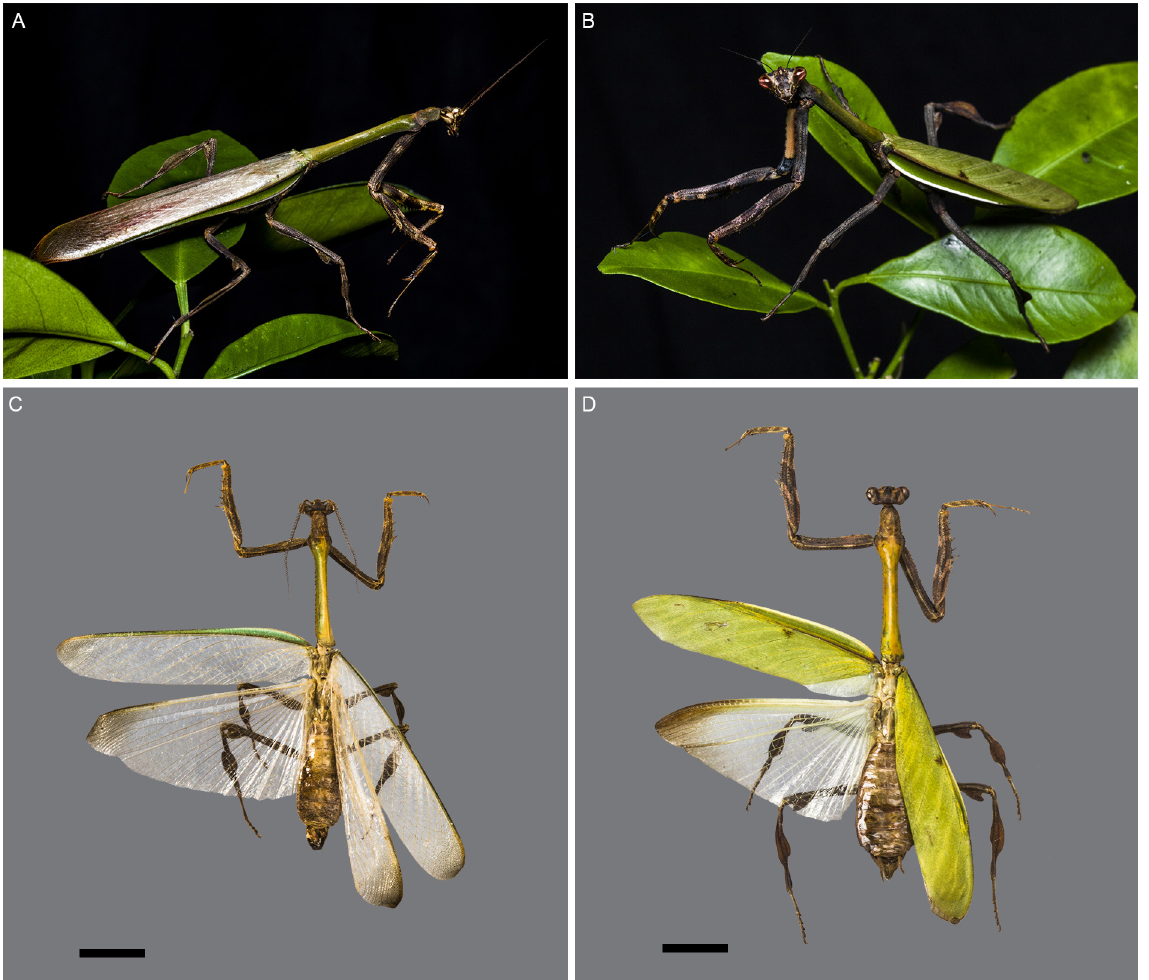
Fig. 2. Adults of Vates phoenix sp. nov. A – B . Live specimens photographed in a studio. A . Paratype, ♂, from Reserva Ecológica de Guapiaçu (MNRJ-ENT6-28446). B . Allotype, ♀, from Jardim Botânico do Rio de Janeiro (MNRJ-ENT6-28442). – C – D . Pinned adults. C . Holotype, ♂, from Fazenda Recanto (MNRJ-ENT6-28441). D . Allotype, ♀ (MNRJ-ENT6-28442). Scale bars: C–D = 10